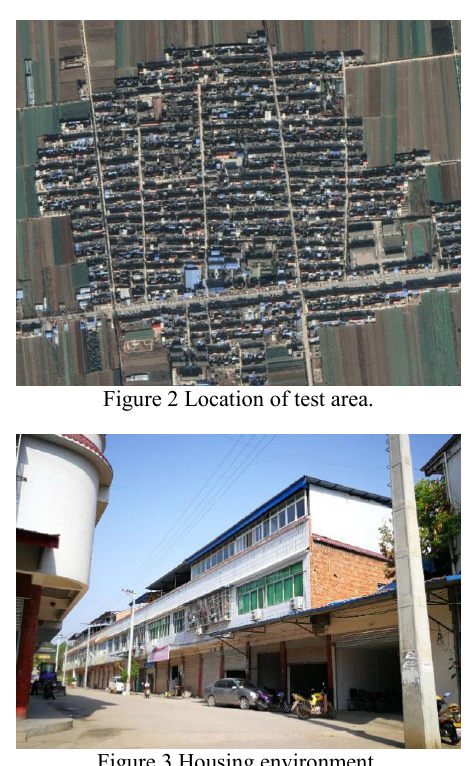
Figure 3 Housing